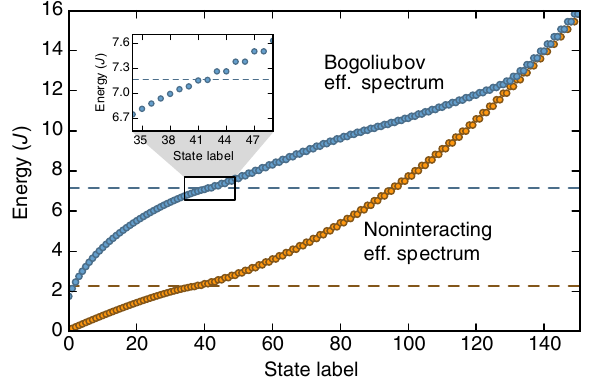
FIG. 6. Energy spectrum of the noninteracting time-averaged Hamiltonian (orange dots) and corresponding effective Bogoliu- ¼ 10 . 2 J in a bov dispersion (blue dots) for α ¼ 1 . 4 and g max ¼ 0 . 26 J= ℏ . The dashed lines indicate the harmonic trap with ω x ¼ 2 . 2 J respective bandwidths in the homogenous case, i.e., ℏ ω sat ¼ 7 . 17 J (blue) according to Eq. (B1). Inset: (orange) and ℏ ω sat As the energy reaches the homogenous bandwidth, the spectrum becomes